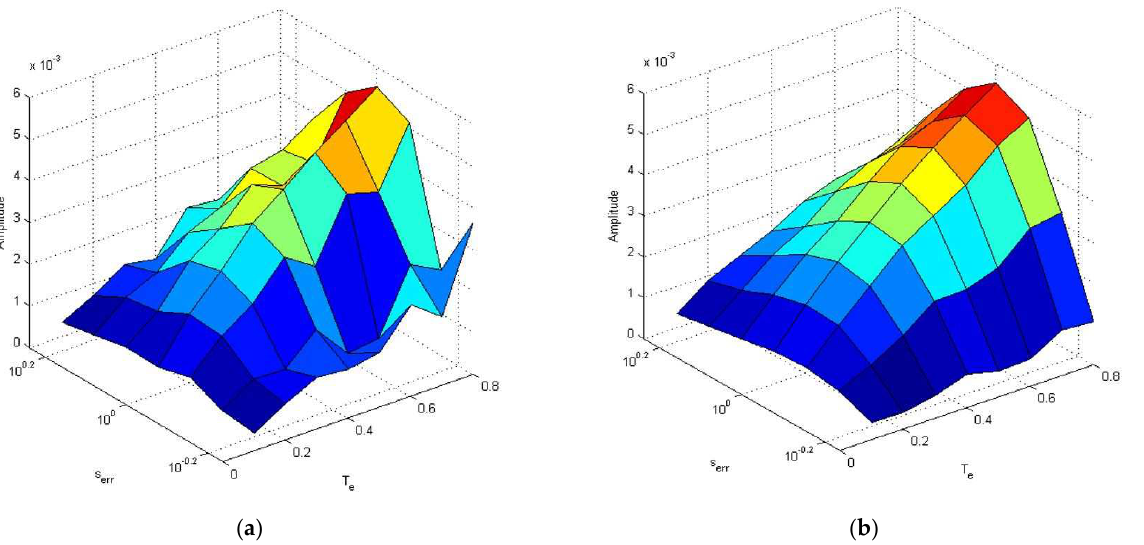
Figure 4. The amplitude of broken rotor harmonic at estimated frequency obtained using ( a ) RDFT and ( b ) GDFT algorithms for variable slip estimation error.